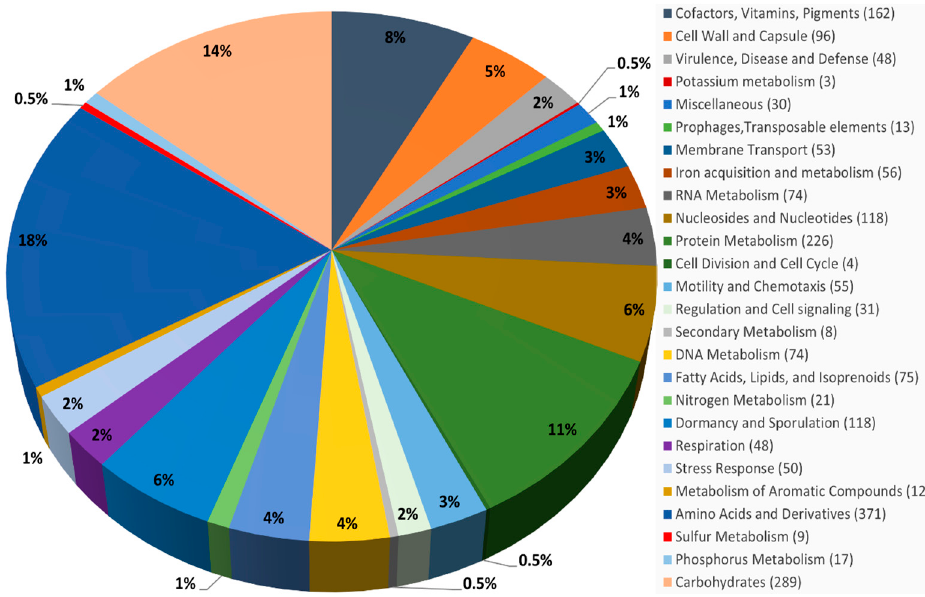
Figure 3. Subsystem category distribution and the biological function of B. subtilis strain RS10 based on RAST genome analysis. The distributions of genes are represented with different colors and their corresponding genes are numerically shown within parenthesis.